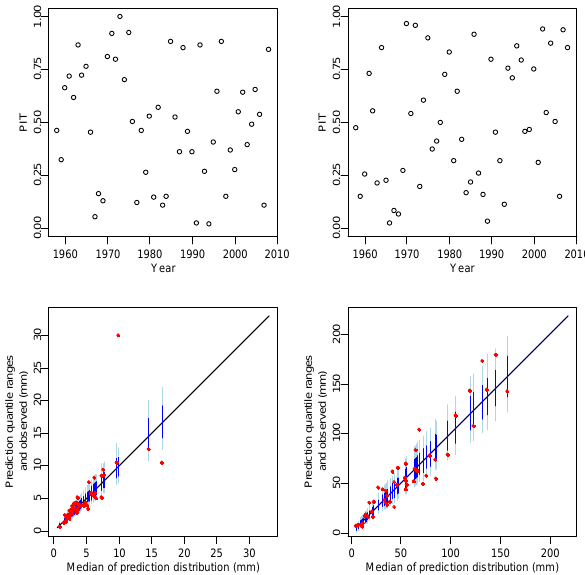
Fig. 6. Top row – probability integral transform (PIT) values plotted Figure 6: Top row - Probability Integral Transform (PIT) values plotted against time for months of 498 against time for the months of February and July; bottom row – February and July; Bottom row - Post-processed quantiles plotted against their median values for 499 post-processed quantiles plotted against their median values for the months of February and July. The red dots represent the observed streamflows, light blue vertical 500 months of February and July. The red dots represent the observed lines represent the 0.1 – 0.9 quantiles and the dark blue lines represent the 0.25-0.75 quantiles. The 501 streamflows, light blue vertical lines represent the 0.1–0.9 quantiles 1:1 lines represent the forecast median. 502 and the dark blue lines represent the 0.25–0.75 quantiles. The 1 : 1 503 lines represent the forecast